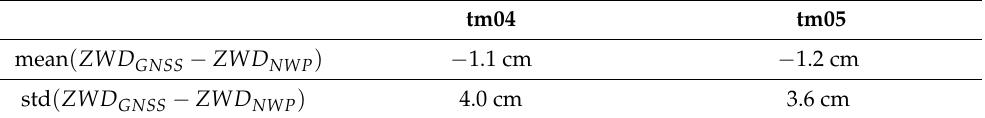
Figure 12. Comparison between GNSS-derived and NWP-model-based measurements. Table 4. Mean and standard deviation of the difference between ZWD values based on GNSS derived measurements and NWP data.